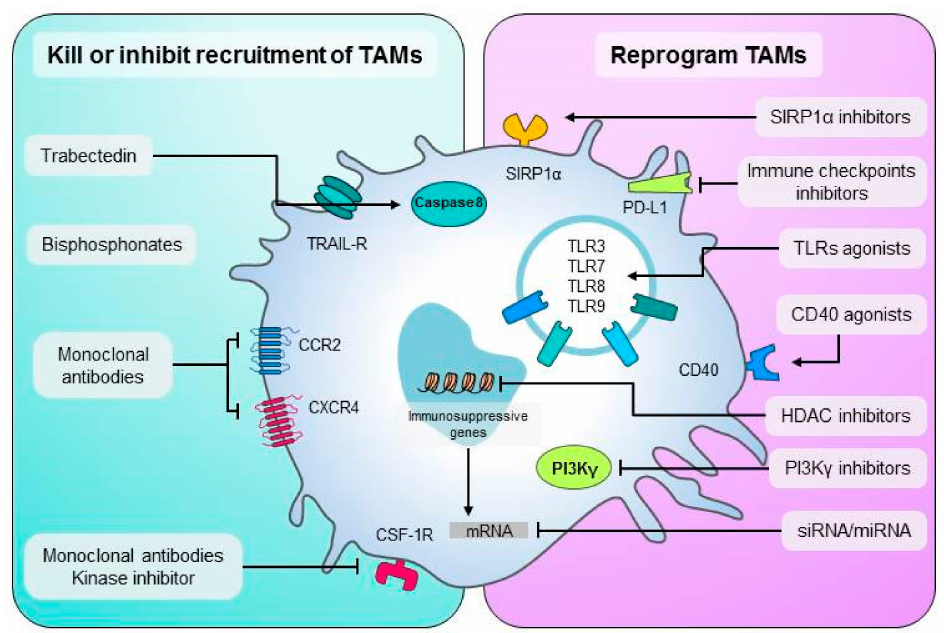
Figure 2. Summary of available therapeutic strategies to target TAMs. On the left side are di ff erent approaches to kill macrophages or inhibit their recruitment in tumors. Monoclonal antibodies or kinase inhibitors have been developed to disrupt the CSF-1 / CSF-1R, CCL2 / CCR2, or the CXCL12 / CXCR4 axis required for the recruitment of new macrophages towards the tumor. Traditional bisphosphonates free or loaded into nanocarriers, and also trabectedin are chemotherapeutics, which showed preferential toxicity towards monocytes / macrophages and have been used to reduce their number in tumors. On the right side are strategies to reprogram TAMs into M1-like anti-tumor e ff ectors. Monoclonal agonist antibodies to CD40 or agonists to Toll-like receptors activate TAMs. SIRP1 α inhibitors prevent the block of phagocytosis; mAbs against immune checkpoint ligands, such as PD-L1, can also target TAMs. RNA-based therapies and some small drugs inhibiting histone acetylation (HDAC) or the PI3Kgamma pathway are also under